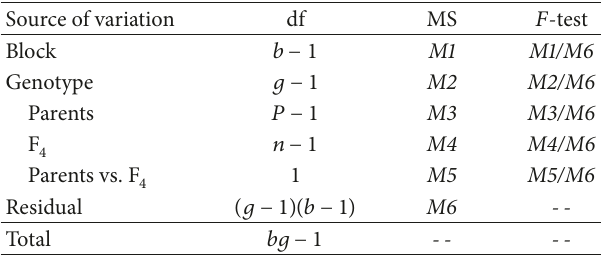
Table 1: The skeleton of the analysis of